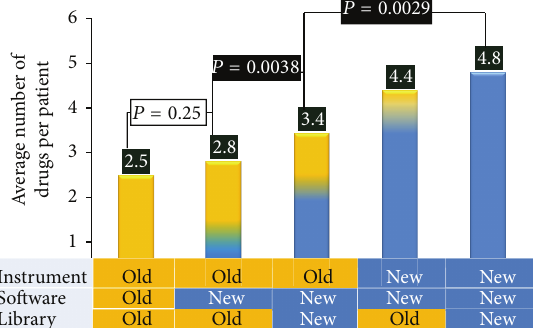
Figure 4: Comparison of the number of drugs identified by the new, reference, and mixed configuration platforms. The number of drugs reported per patient is shown against each configuration, and the statistical significance ( 𝑃 value) in the differences in the number of drugs reported for three configurations compared is provided. Statistically valid ( 𝑃 value = 0.0038) increment in the numberofdrugswasreportedwhenthedatafromthereferenceGC- MS instrument is analyzed using AMDIS in conjunction with the new in-house library compared to the use of the default data analysis approach. In-addition, both data generated using the reference instrument and that by the new platform were analyzed using AMDIS in conjunction with the new in-house library. The results from this comparison show that an even higher and statistically significant ( 𝑃 value = 0.0029) increment in the number of drugs was reported from the data generated by the new platform compared to the data generated by the reference